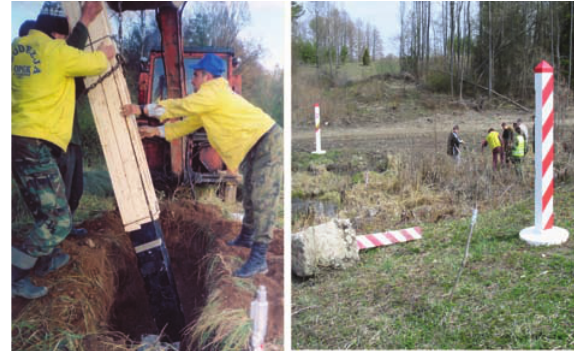
Fig. 4. Poland and the Soviet Union’s State borders mark Fig. 5. State border demarcation marks renewal works in